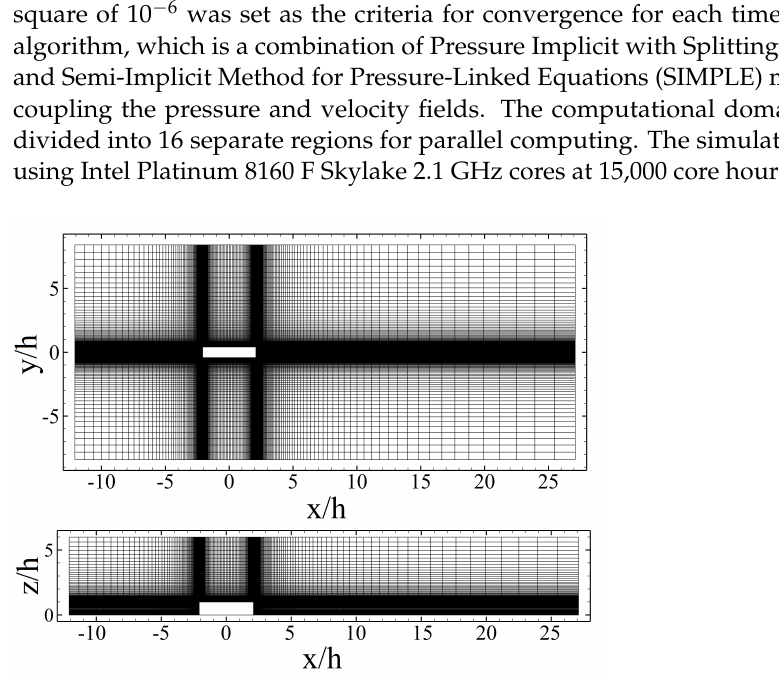
Figure 4. The spatial grid distribution for the long prism at Re = 250. Top view at z / h = 0.5 ( top ) and side view at y / h = 0 ( bottom